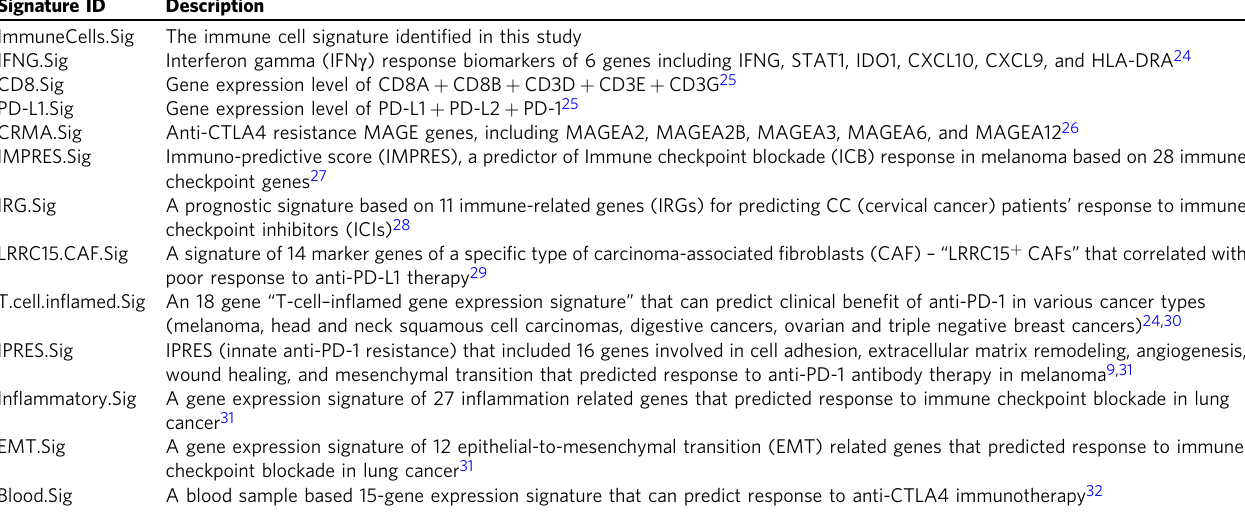
Table 1 The list of biomarkers for response to immune checkpoint therapy that were compared in this